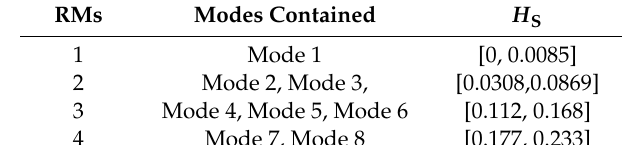
Table 4. Reconstructed RM derived by EWT according to SE.